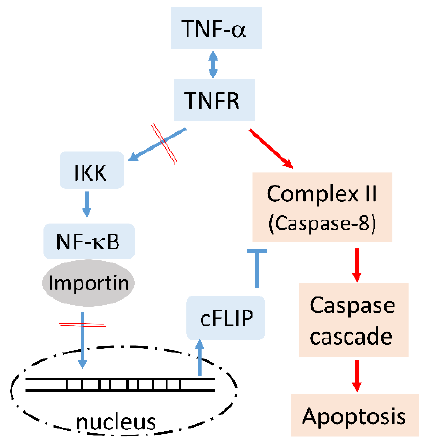
Figure 7. The possible mechanisms of MCPIP1 enhanced TNF- α -induced apoptosis. TNF- α binds to TNF receptor (TNFR) and transduces at least cell survival (blue line) and apoptosis (red line) signals. MCPIP1 may inhibit IKK activation and NF- κ B translocation through its deubiquitinase and RNase, respectively, and finally downregulates cFLIP expression. The uninhibited caspase-8 causes cell apoptosis through the caspase cascade pathway.